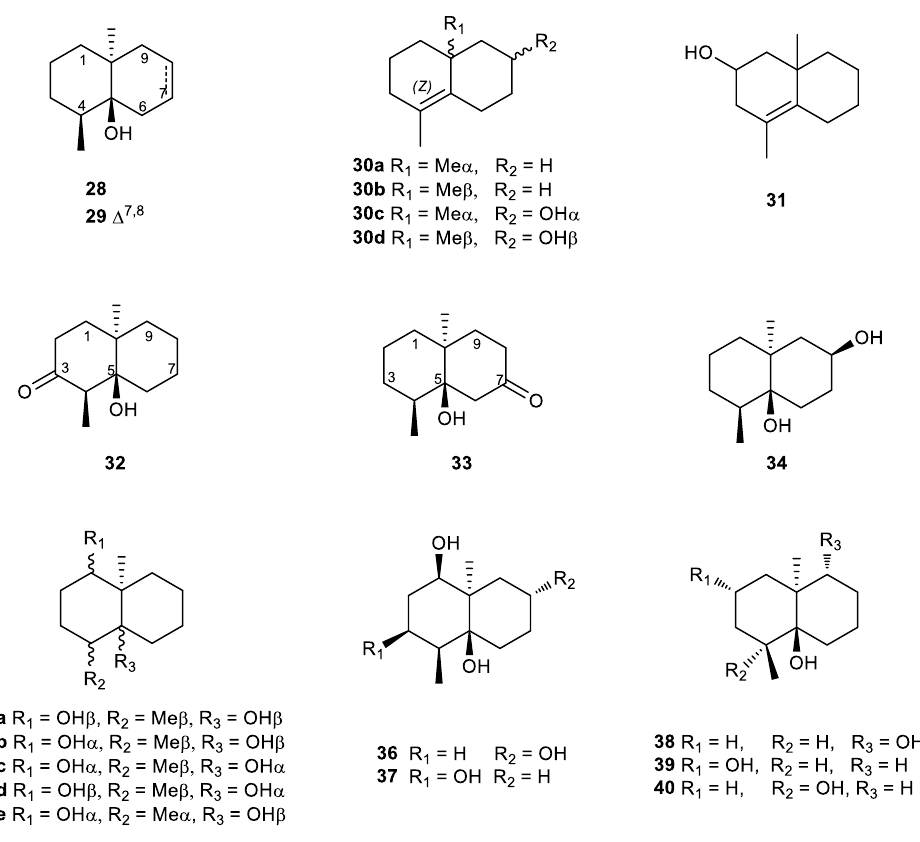
Figure 5. Geosmin and derivatives.